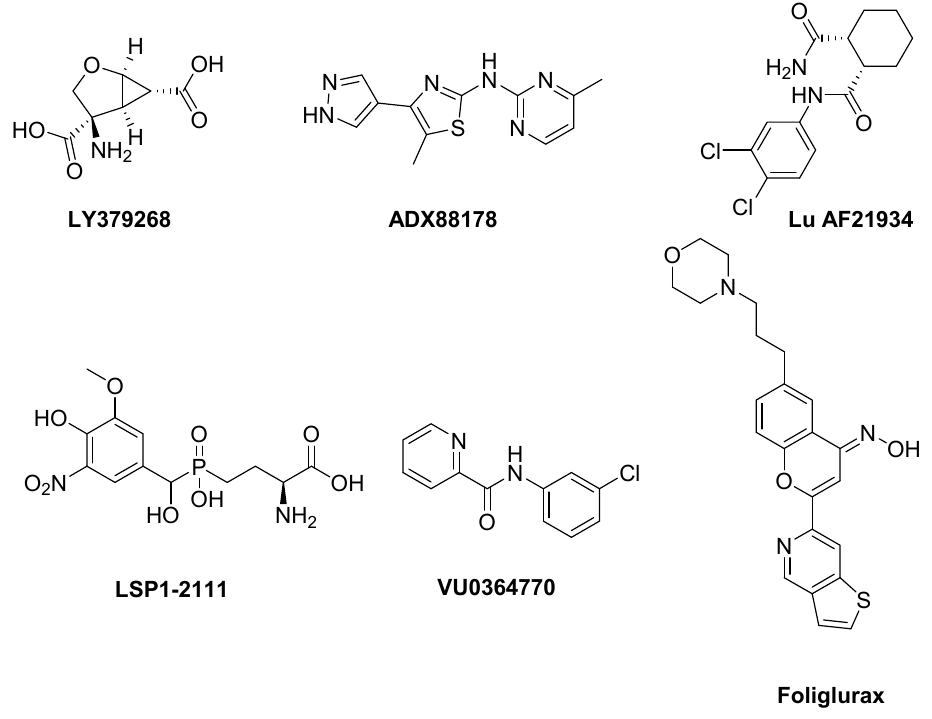
/ 3R and mGlu4R Figure 7. mGlu2/3R and mGlu4R ligands. Figure 7. mGlu2